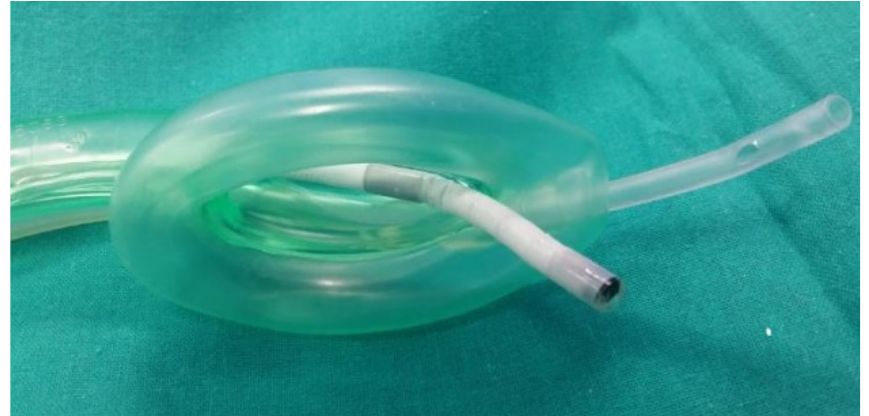
Figure 4. Distal end of the laryngeal mask airway. Exit of the fiberscope into the airway (white) and of the nasogastric tube into the esophagus (transparent).